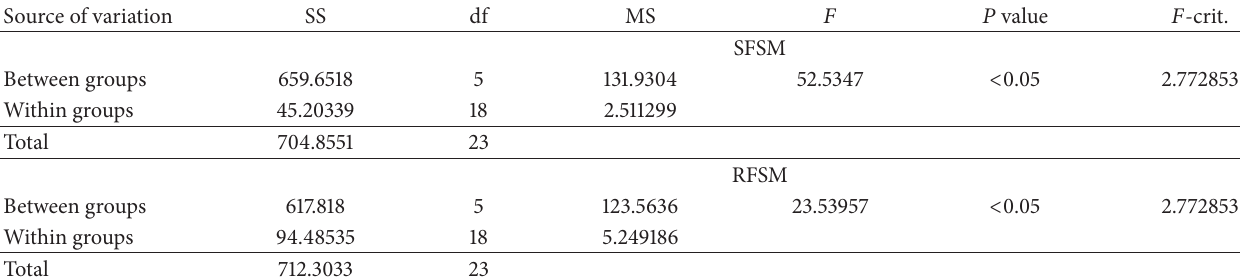
Table 13: ANOVA results for specificity of classifiers.